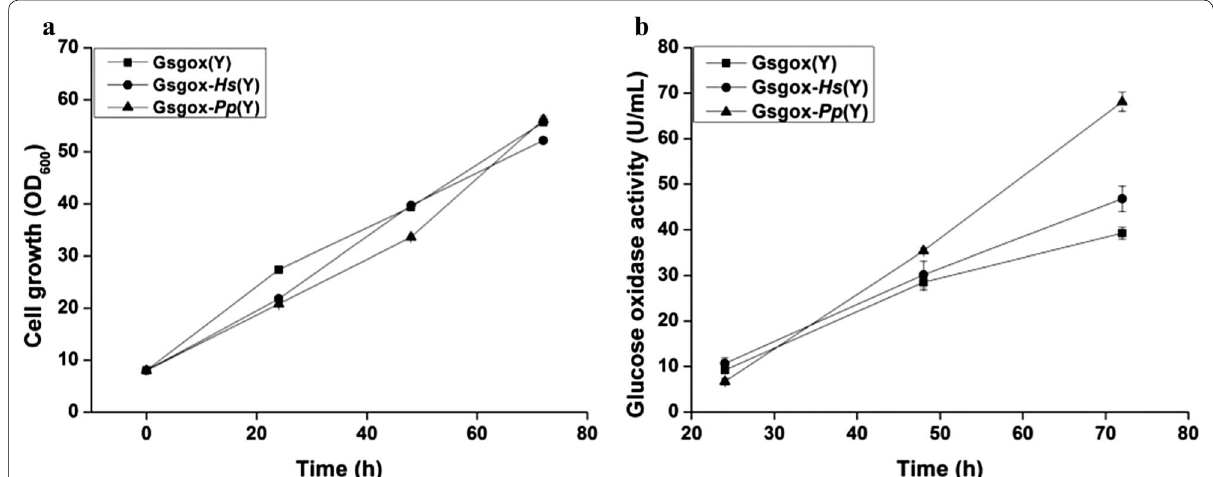
Fig. 4 Synergistic effect of Hac1p and YE co-feeding on Gox production. a Cell growth profile. b Gox activity profile. (Y) Co-feeding with yeast extract, (S) Co-feeding with sorbitol. GSgox co-fed with yeast extract (square), GSgox- Hs co-fed with yeast extract (circle) and GSgox- Pp co-fed with yeast extract (triangle). Three parallel flasks are tested for each strain at 30 °C. Error bars represent deviations ( n